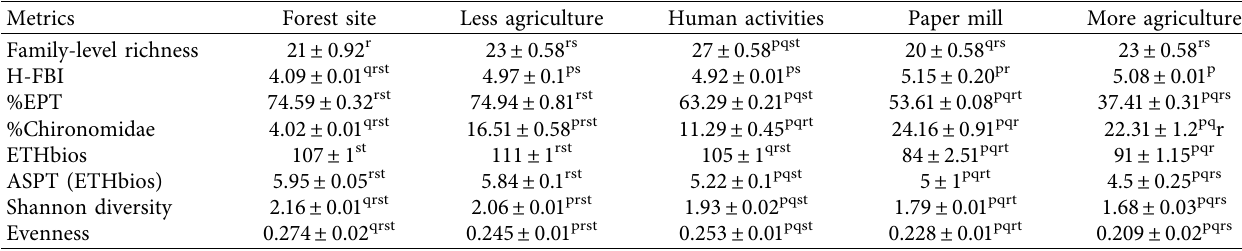
Table 3: Biotic indices calculated from all sampling